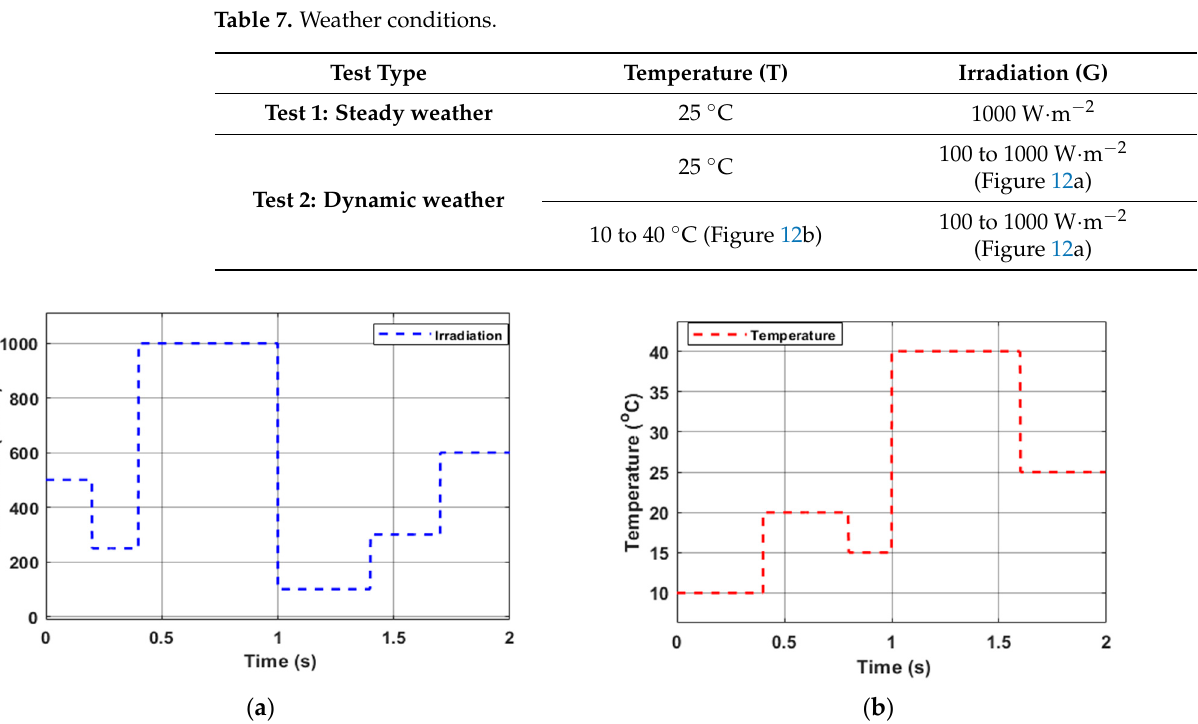
Table 8. Parameters needed to simulate the MPPT